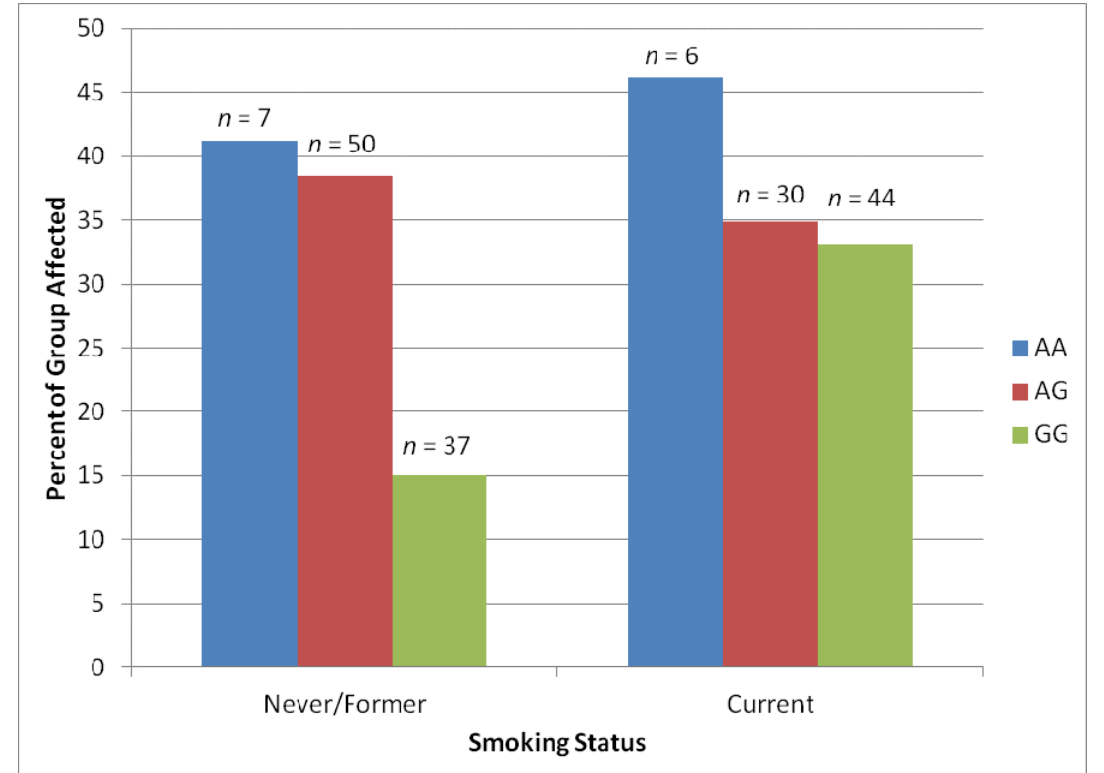
Figure 2. Percents of persons within groups defined by both smoking status and rs733048 genotype who are affected